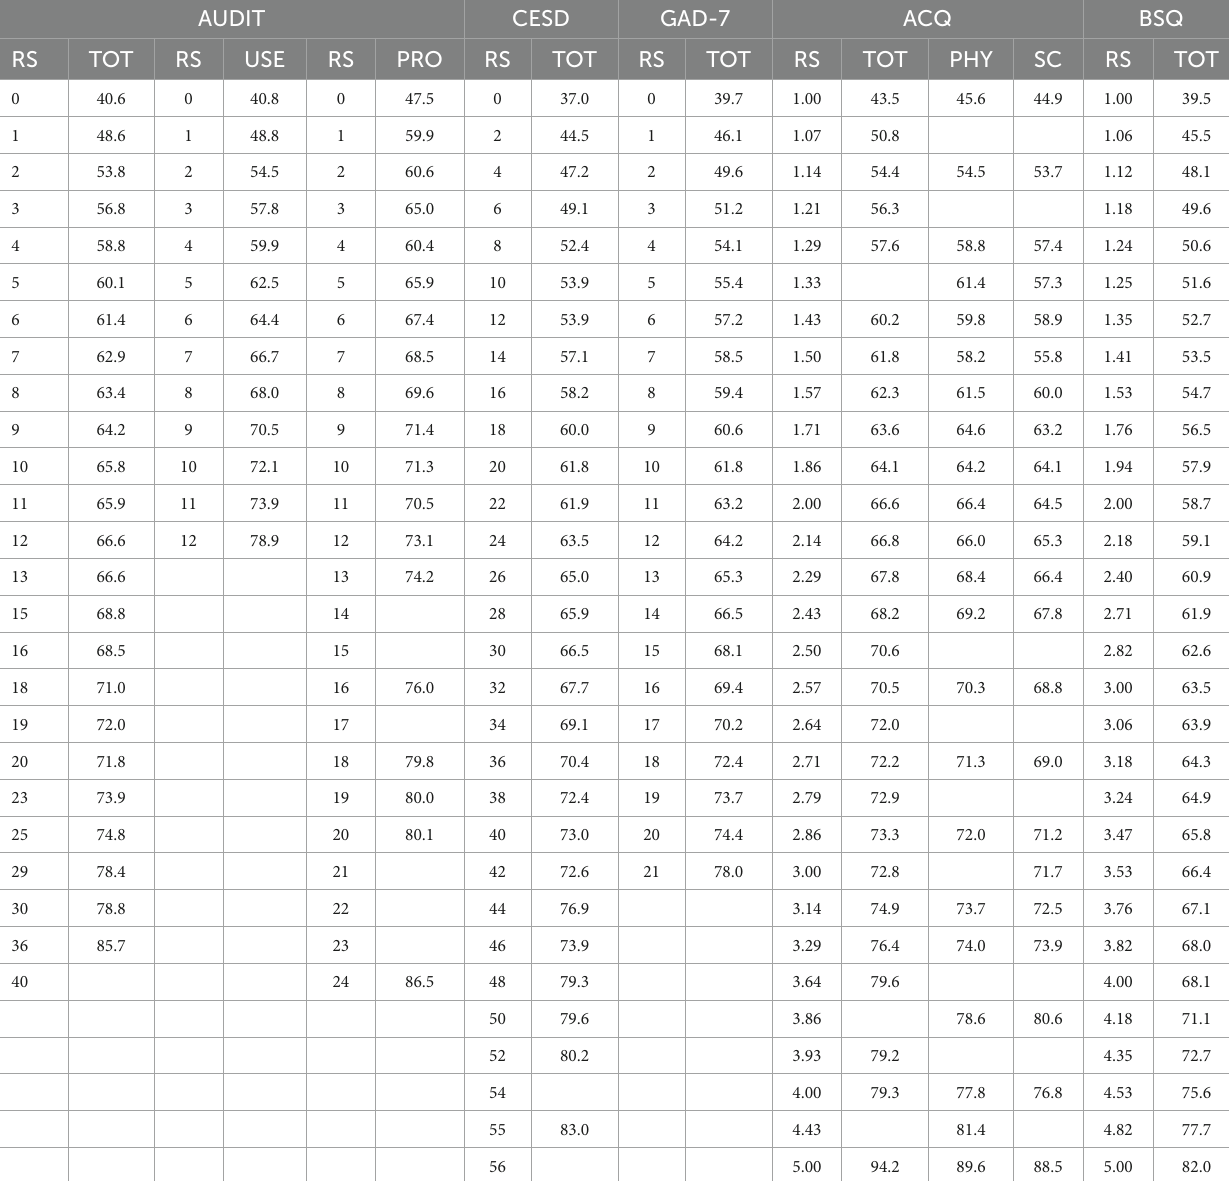
TABLE 7 Crosswalk table from raw scores to theta-based